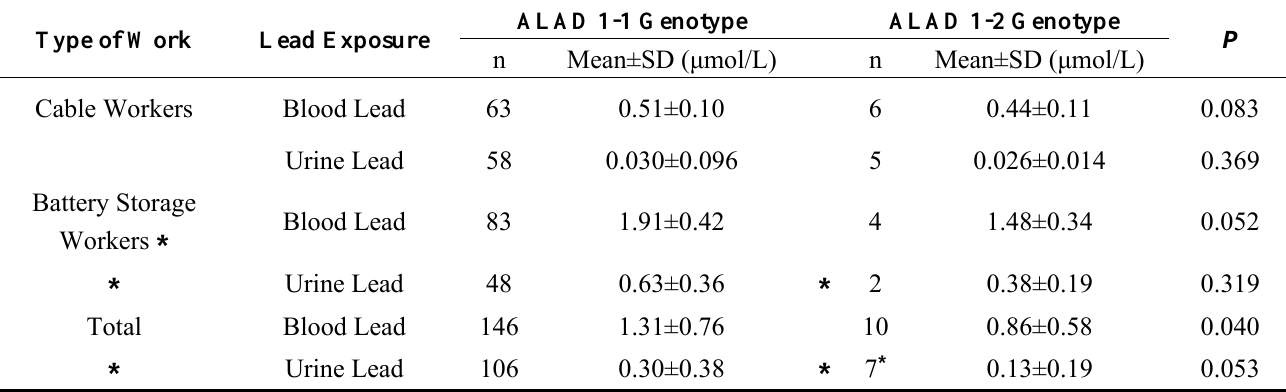
Table 1. Blood and urine lead levels by